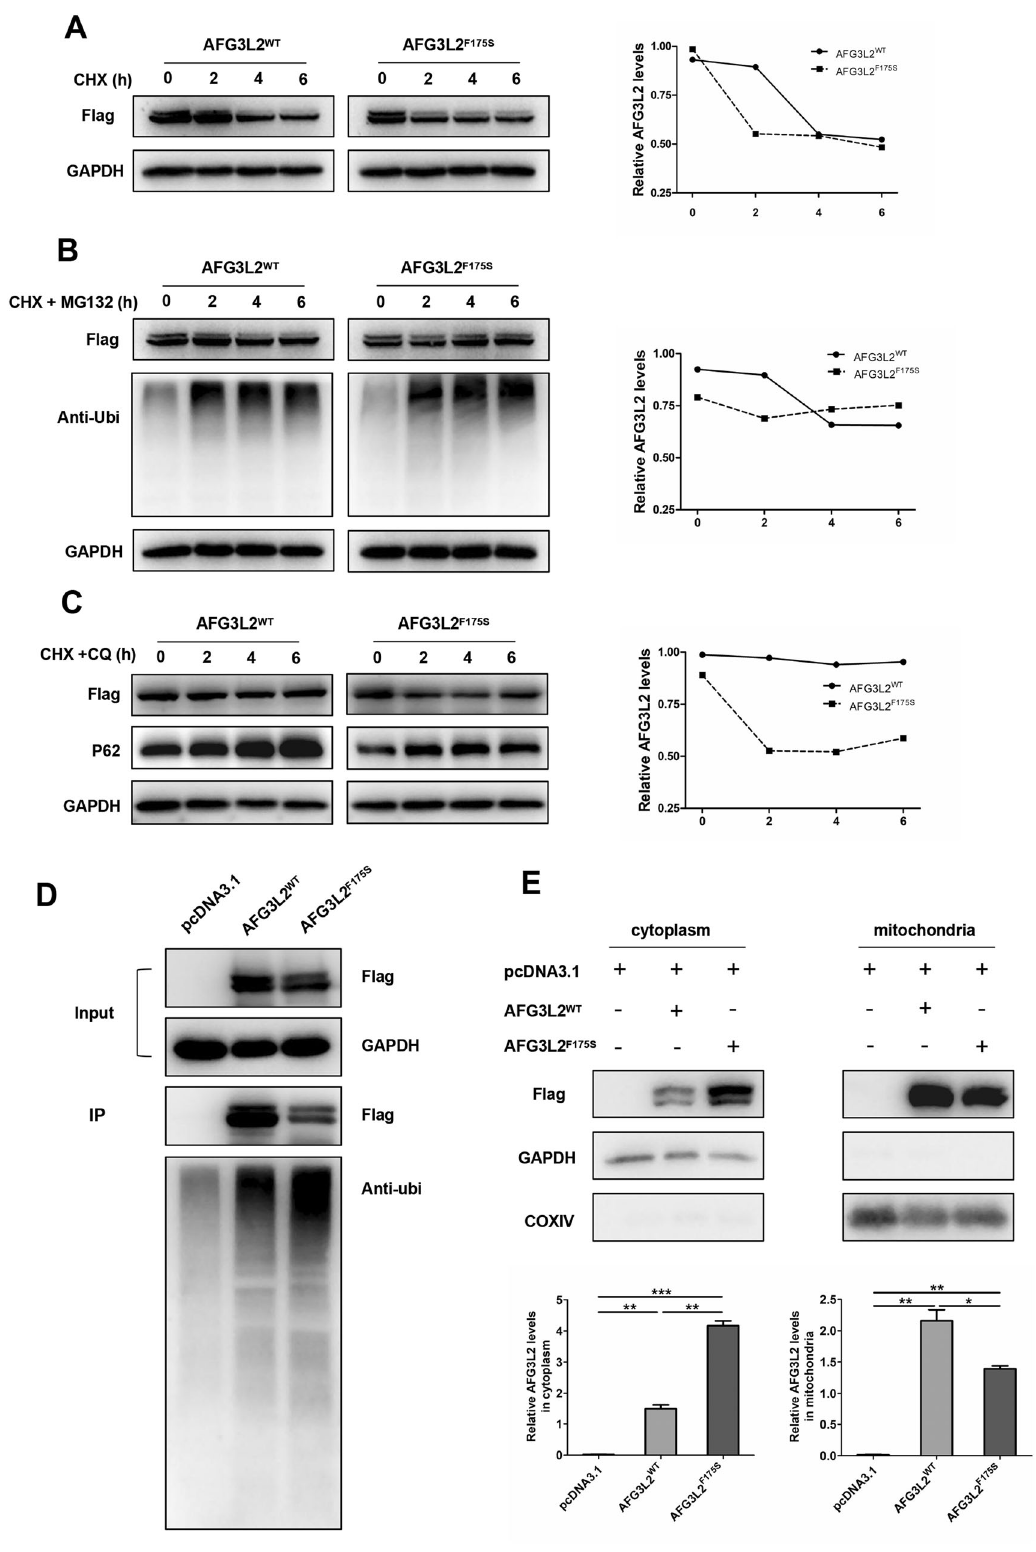
Fig. 5 F175S mutation damaged the stability of AFG3L2 protein may through the ubiquitination-proteasome pathway. A HEK293T cells were transfected with wild type and F175S mutant plasmids for 24 h, and treated with 100 μ M CHX, the expression of AFG3L2 protein was detected. B, C AFG3L2 protein stability was detected after cells were treated with 50 μ M MG132 and 20 μ M chloroquine, respectively. D 24 h after transfection, wild type and mutant AFG3L2 proteins were enriched by immunoprecipitation, and their ubiquitination levels were detected. E Wild and mutant AFG3L2 proteins in mitochondria and cytoplasm. (Values expressed as mean ± SD, * p < 0.05, ** p < 0.01, *** p < 0.001).